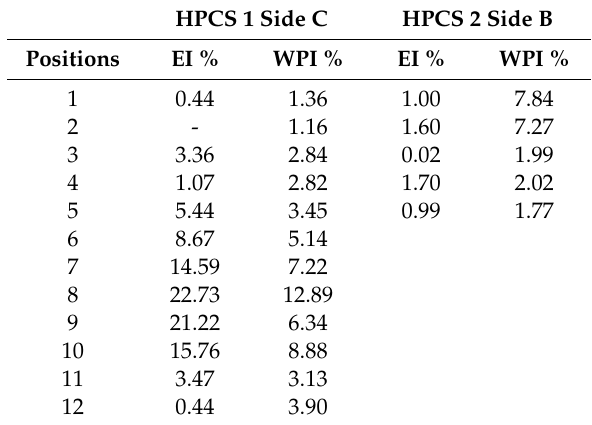
Table 9. User interface unit: EIs and WPIs for HPCS 1 side C and HPCS 2 side